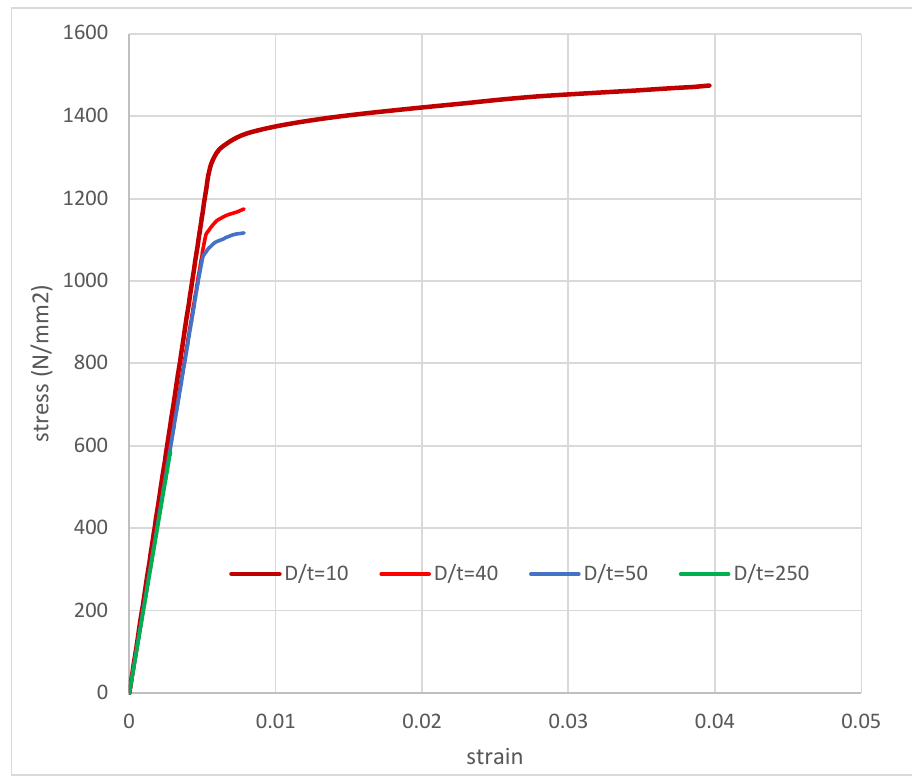
Figure 12. Stress–strain curve of specimens of D / t = 10, 40, 50 and D / t = 250 (LC1, S1100). For specimen tubes with D / t ≥ 110 for HSS-S460 and D / t ≥ 40 for UHSS-S1100, respectively, it is found that the outward deformations were like an elephant’s foot buckle that occurred at the two ends as the previous specimens but with little shape. In addition, there are sharp deformations occurring along the length of each tube typical of the failure mode of slender tubes due to local buckling behavior as shown in Figures 9 and 10, respectively. All these types of specimens in this range of D / t were not able to reach their yield stress as shown in Figures 12 and 13 because they failed in the elastic stage due to local buckling. It is concluded that these specimens behave as slender tubes.